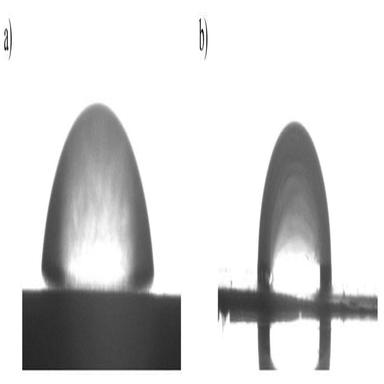
Digital image of a water drop on top of a) neat TPU waste and b) 2TD-TPU15 electrospun mat.